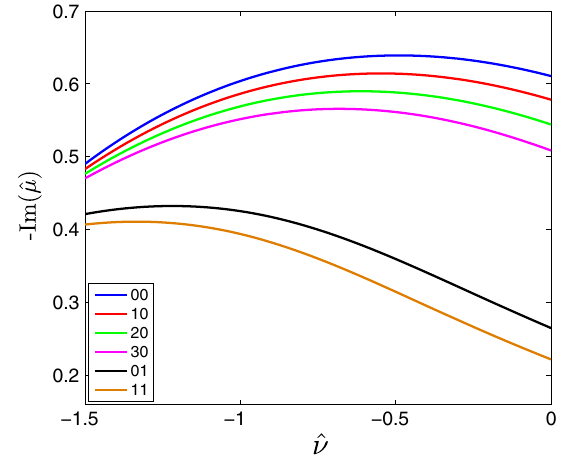
FIG. 3. Negative imaginary part of the FEL growth rate μ (in k units of 2 ρ ) as a function of the detuning Δ ν (in units of 2 ρ T u for several FEL modes (data from the analytical solution, for the η ¼ 1 cm case).